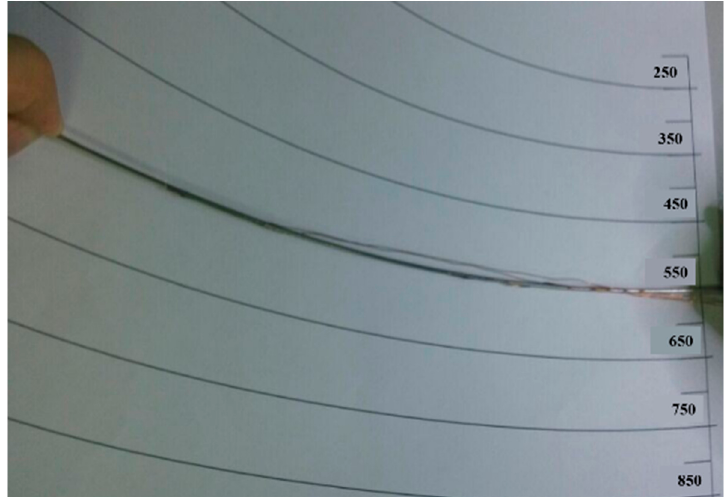
Figure 14. Single arc experiment.